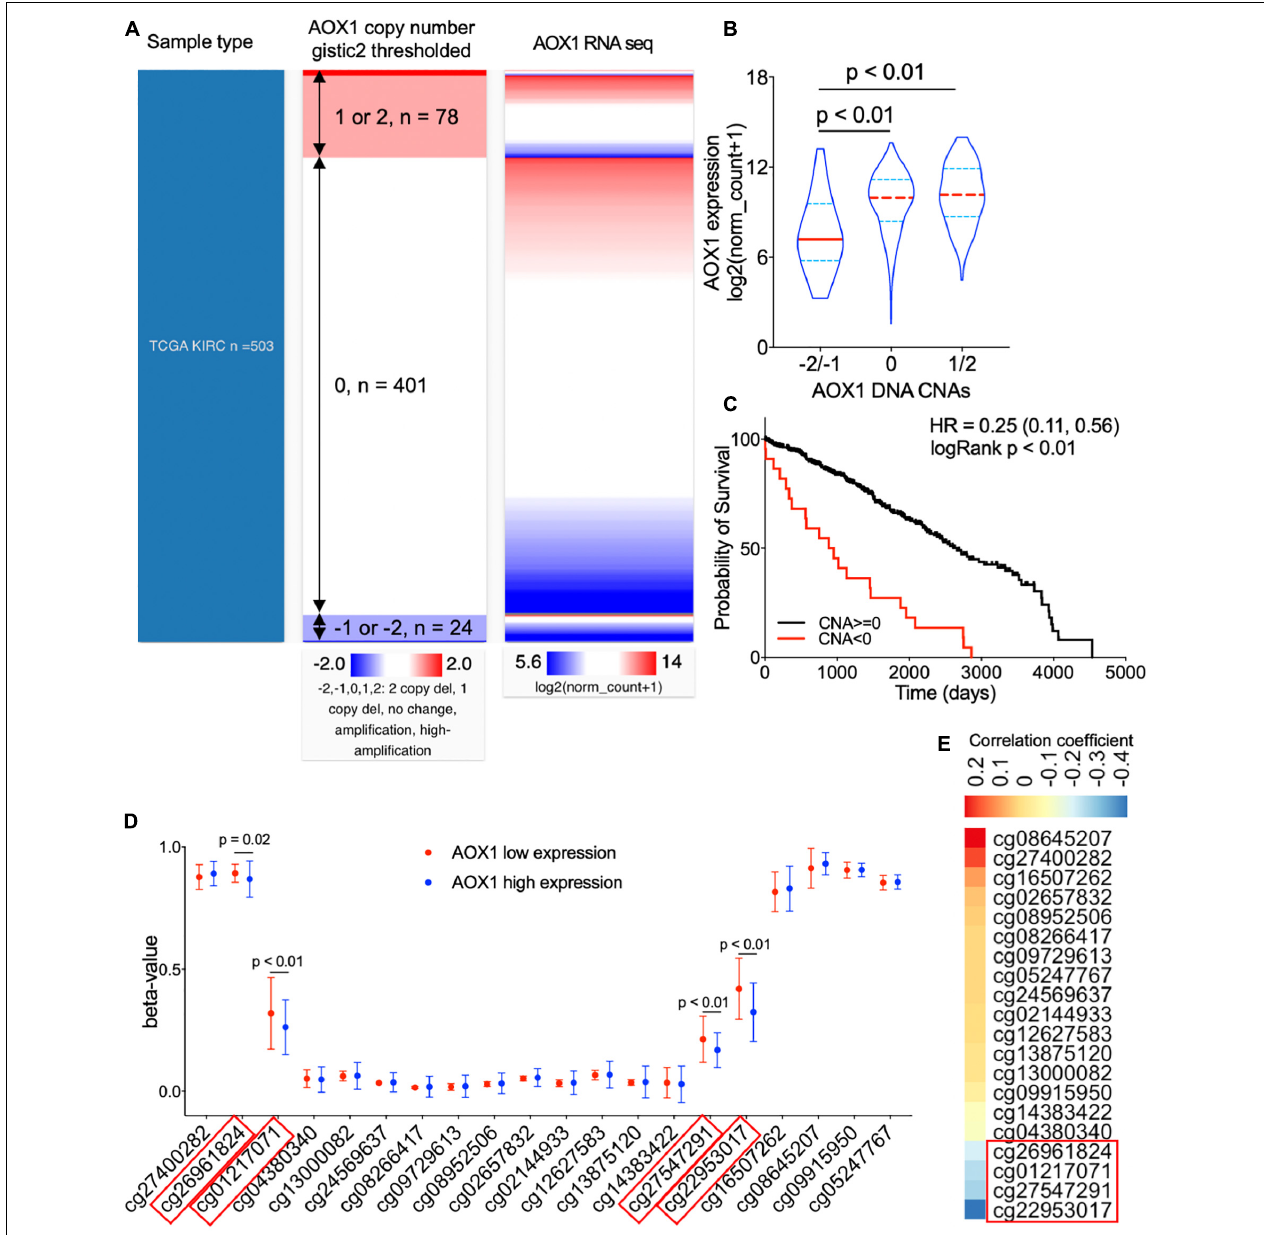
FIGURE 6 | Genetic alterations of AOX1 gene in clear cell renal cell carcinoma (ccRCC) patients. (A) Heat map showing the correlation between AOX1 DNA copy number alteration (CNA) and its expression. (B) Violin plot showing AOX1 expression in different CNA groups. CNAs were defined as follows: no change (0), heterozygous deletion (–1), homozygous deletion (–2), amplification (1), and high amplification (2). n = 23, n = 401, and n = 78 for –2/–1, 0, and 1/2 groups respectively. (C) Kaplan–Meier curve of ccRCC patients subgrouped by AOX1 DNA CNAs shows worse overall survival in ccRCC patients with copy number deletions in the AOX1 gene. n = 23 and n = 479 for CNA < 0 and CNA ≥ 0, respectively. (D) Methylation levels (beta-value) of CpG site in AOX1 DNA locus subgrouped by AOX1 expression level. n = 125 and n = 177 for AOX1 low expression and high expression, respectively. (E) Heat map showing the correlation between AOX1 expression and CpG site methylation level of AOX1 DNA. Color bar indicates Pearson’s correlation coefficient.